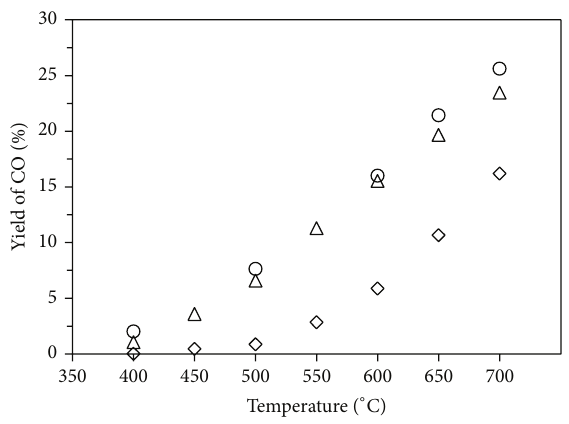
= 𝑃 = 1 kPa, balance H 2 CO 2